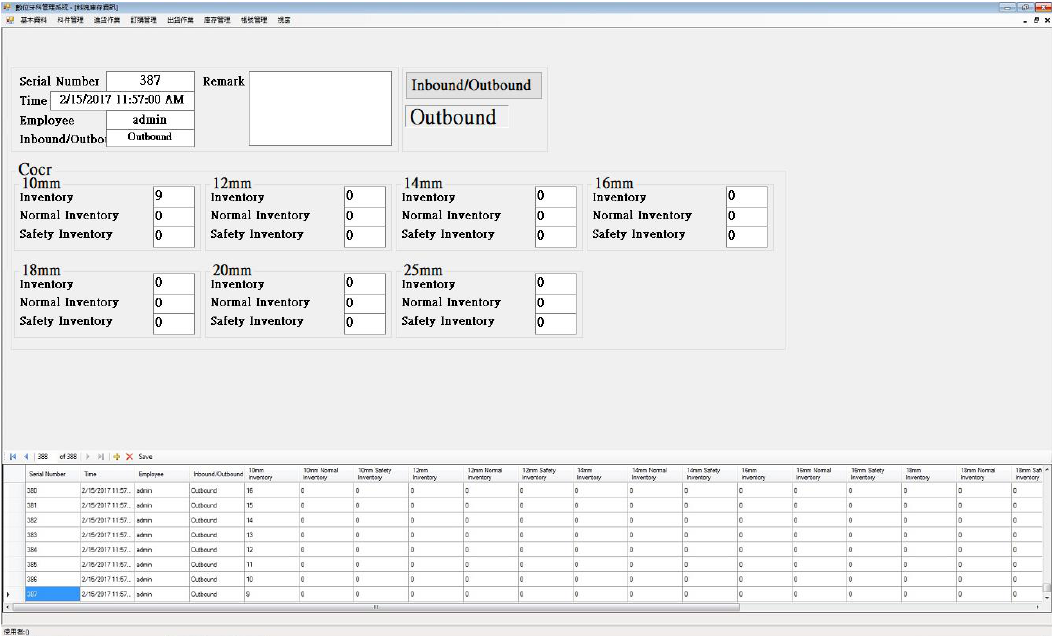
Figure 7. The human – machine interface of the material inventory system. Figure 7. The human–machine interface of the material inventory